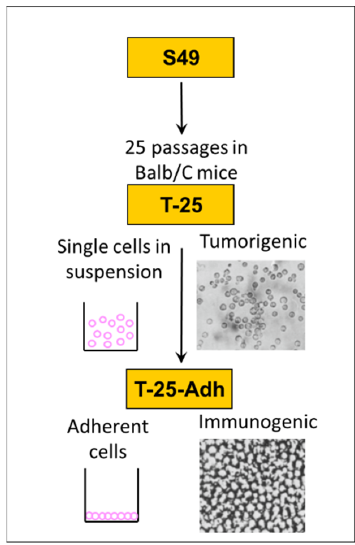
Figure 1. The S49 cell lineage. From highly tumorigenic T ‐ 25 cells that grow as single cells in suspension, non ‐ tumorigenic (immunogenic) substrate adherent variants were derived through spontaneous selection.